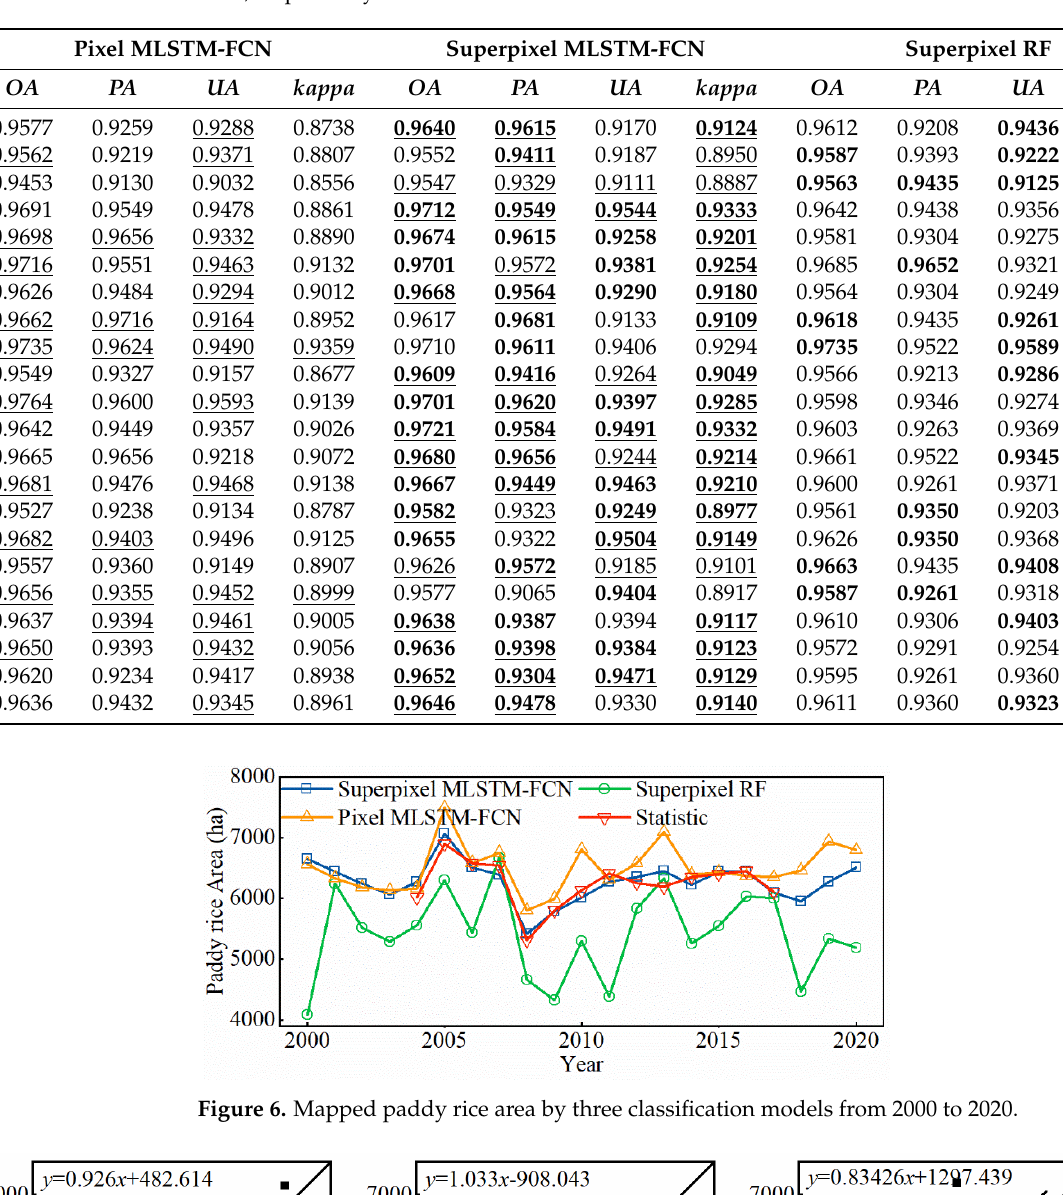
Table 2. Overall Accuracy (OA) , Producer’s Accuracy (PA) , User’s Accuracy (UA) , and kappa of the annal paddy rice classifiers. Bold font and underlined values represent the maximum values of evaluation metrics for comparing superpixel MLSTM-FCN with superpixel RF and pixel MLSTM- FCN, respectively.